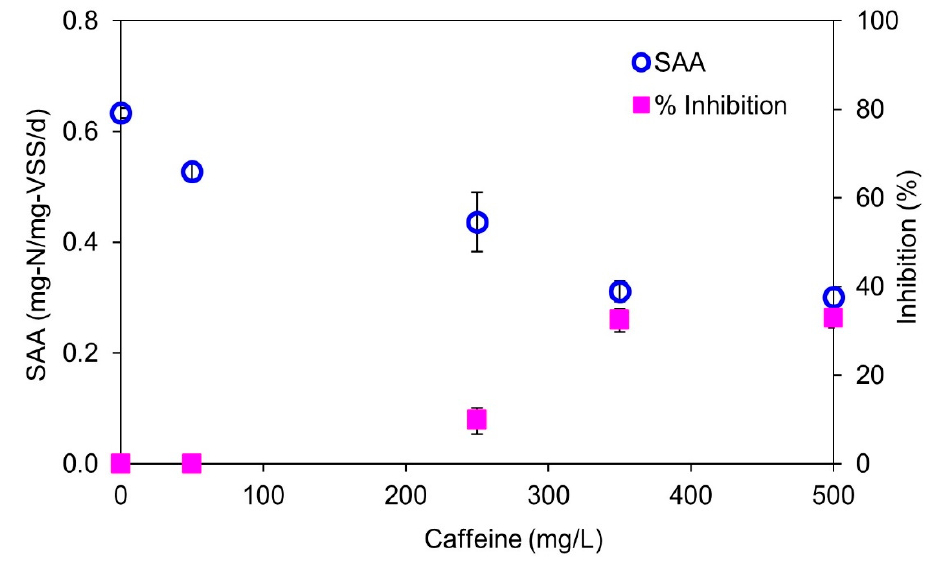
Figure 2. Specific anammox activity (SAA) and percent inhibition versus the acute caffeine dosing concentration.